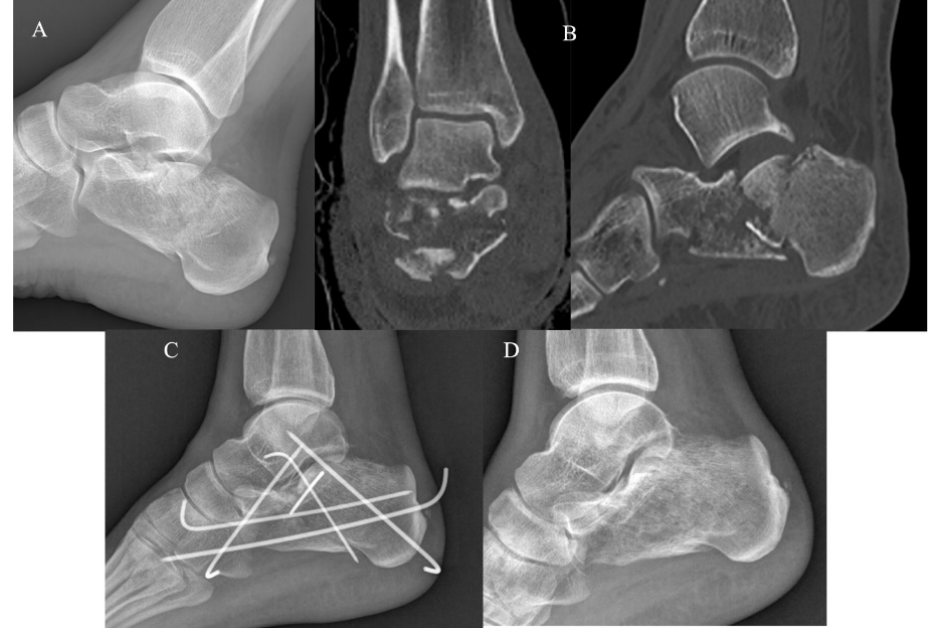
Figure 2. Mini-open approach and K-wire fixation. ( A ) Pre-operative radiographs; ( B ) pre-operative CT scan in coronal and sagittal plane showing a Sanders III CF; ( C ) post-operative radiograph control; ( D ) post-operative radiographs at 4-year